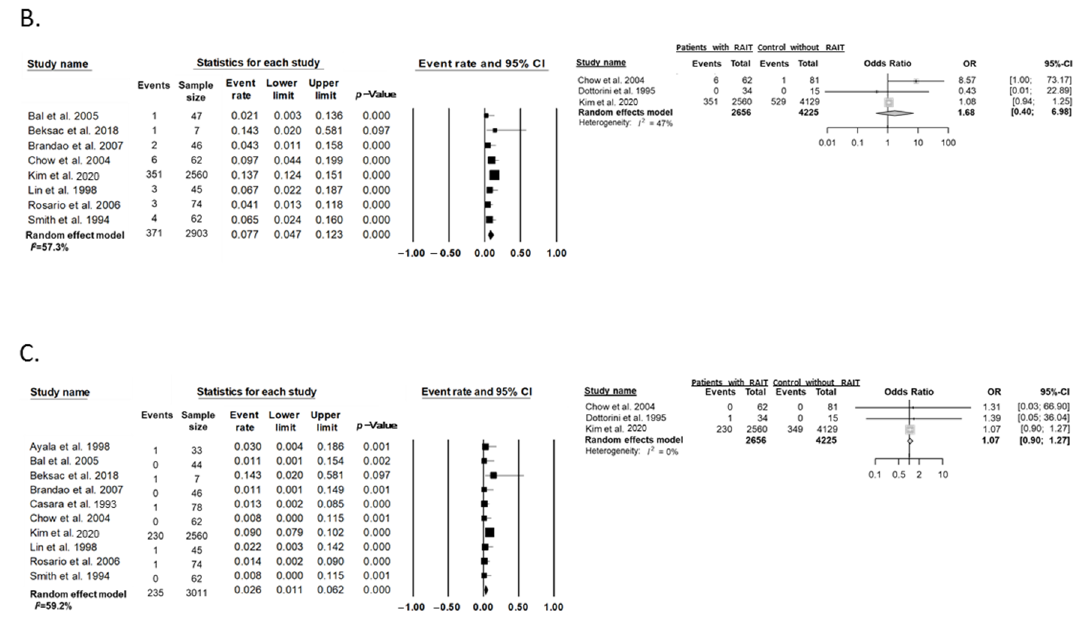
Figure 6. The risk of adverse pregnancy outcomes in patients with an interval of 1 year or more between conception and RAIT. Effect of RAIT on adverse pregnancy outcomes. ( A ) Miscarriage or abortion, ( B ) preterm labor, and ( C ) congenital anomalies. * The study was classified as a case series design because one arm data of patients with thyroid cancer was used in the study. Studies referenced: [14,20,22,26,28–36,38–41].